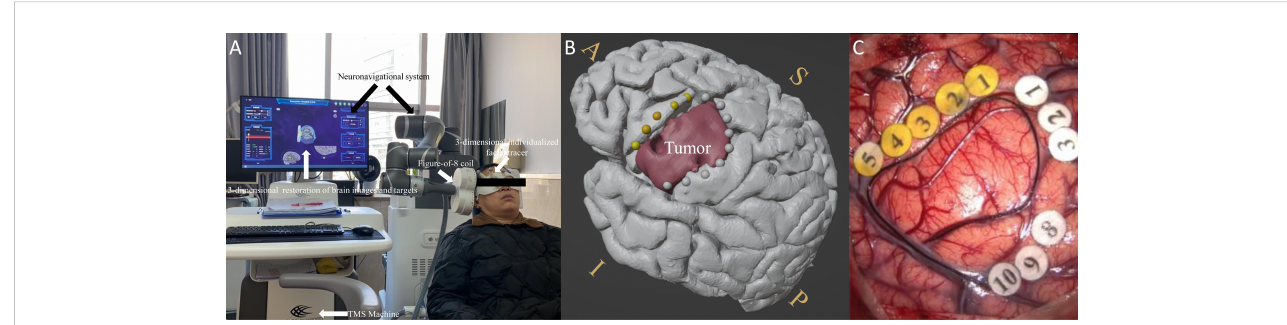
FIGURE 1 (A) Experimental set-up with labeled devices with picture of the IT-TMS system used for preoperative functional mapping prior to brain tumor surgery. The monitor shows a 3D-reconstruction of the brain with coil localization. (B) Preoperative language-positive mapping sites in one patient. (C) The intraoperative functional boundary in the same patient. The yellow dots and numbers indicate language-interrupted areas; the grey dots and white numbers indicate the peritumoral mouth and facial motor areas. The red color indicates the area of the tumor. A similar distribution of positive language- related sites was observed between pre-operation and intra-operation. S, superior; I, inferior; A, anterior; P,